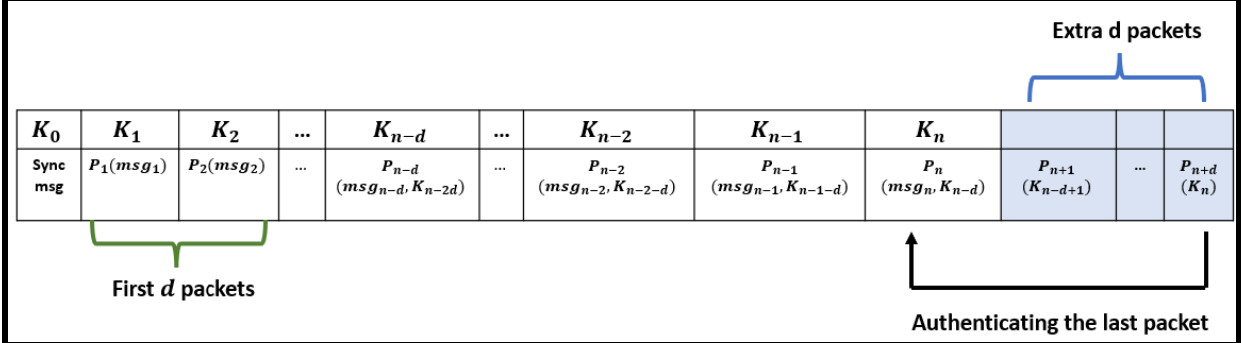
Figure 3. Handling the first and the last exceptional low-level packets in the Hybrid TLI- µ TESLA Protocol.